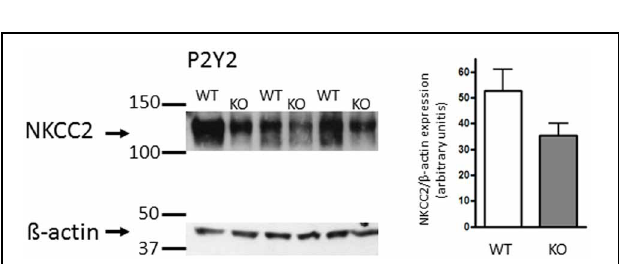
FIGURE 4 | Western blot revealing similar expression of NKCC2 in P2Y 2 receptor WT and KO ( n = 3 each) inner stripe of outer medulla kidney tissue. Right side: The NKCC2 densitometric analysis is shown in reference to the equal dye loading control with β -actin.